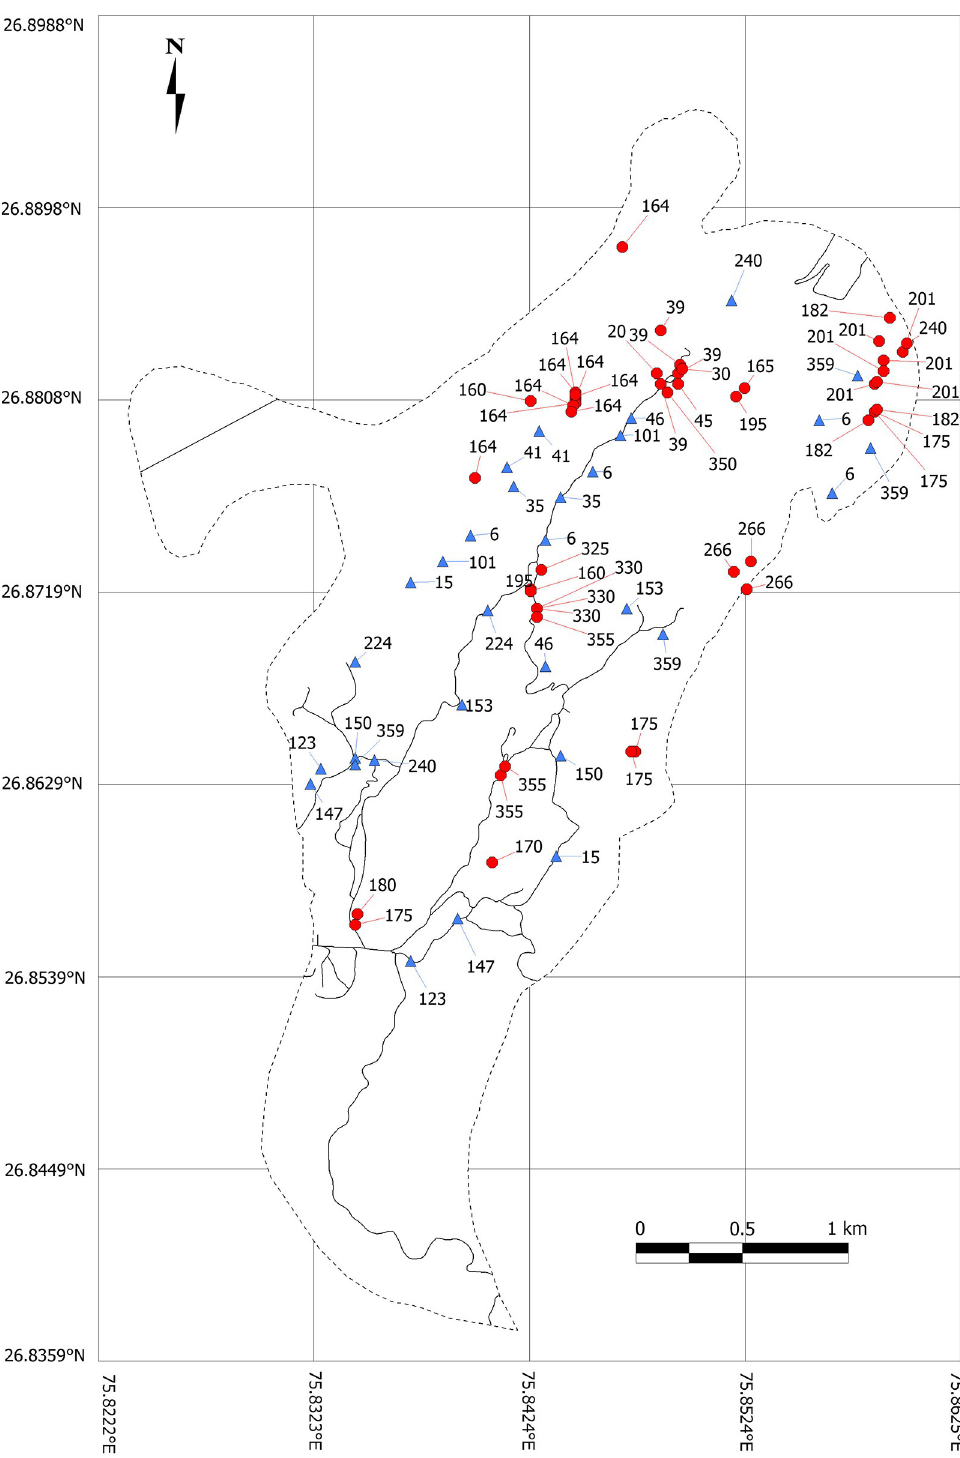
Fig 1. Map of the Jhalana Forest Reserve. Red circles denote the location of defecation, blue triangles leopards ( Panthera pardus fusca ) walking, numbers indicate azimuth of head orientation, and black lines represent roads or dirt tracks.